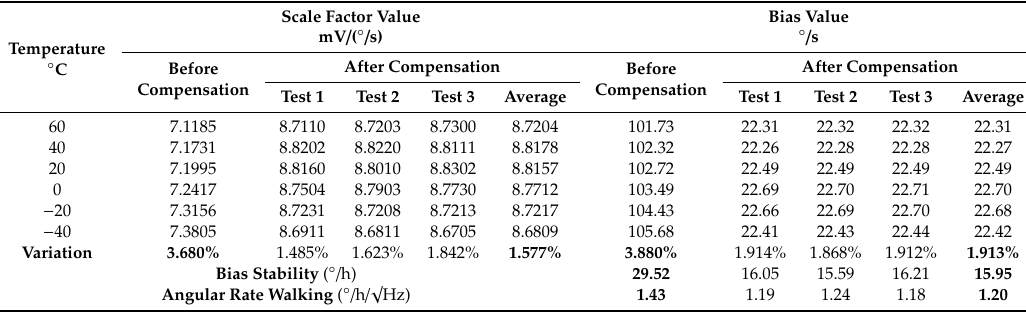
Figure 13. Allan derivation curves of MEMS gyroscope bias before and after temperature compensation. Table 6. MEMS gyroscope temperature compensation test result.